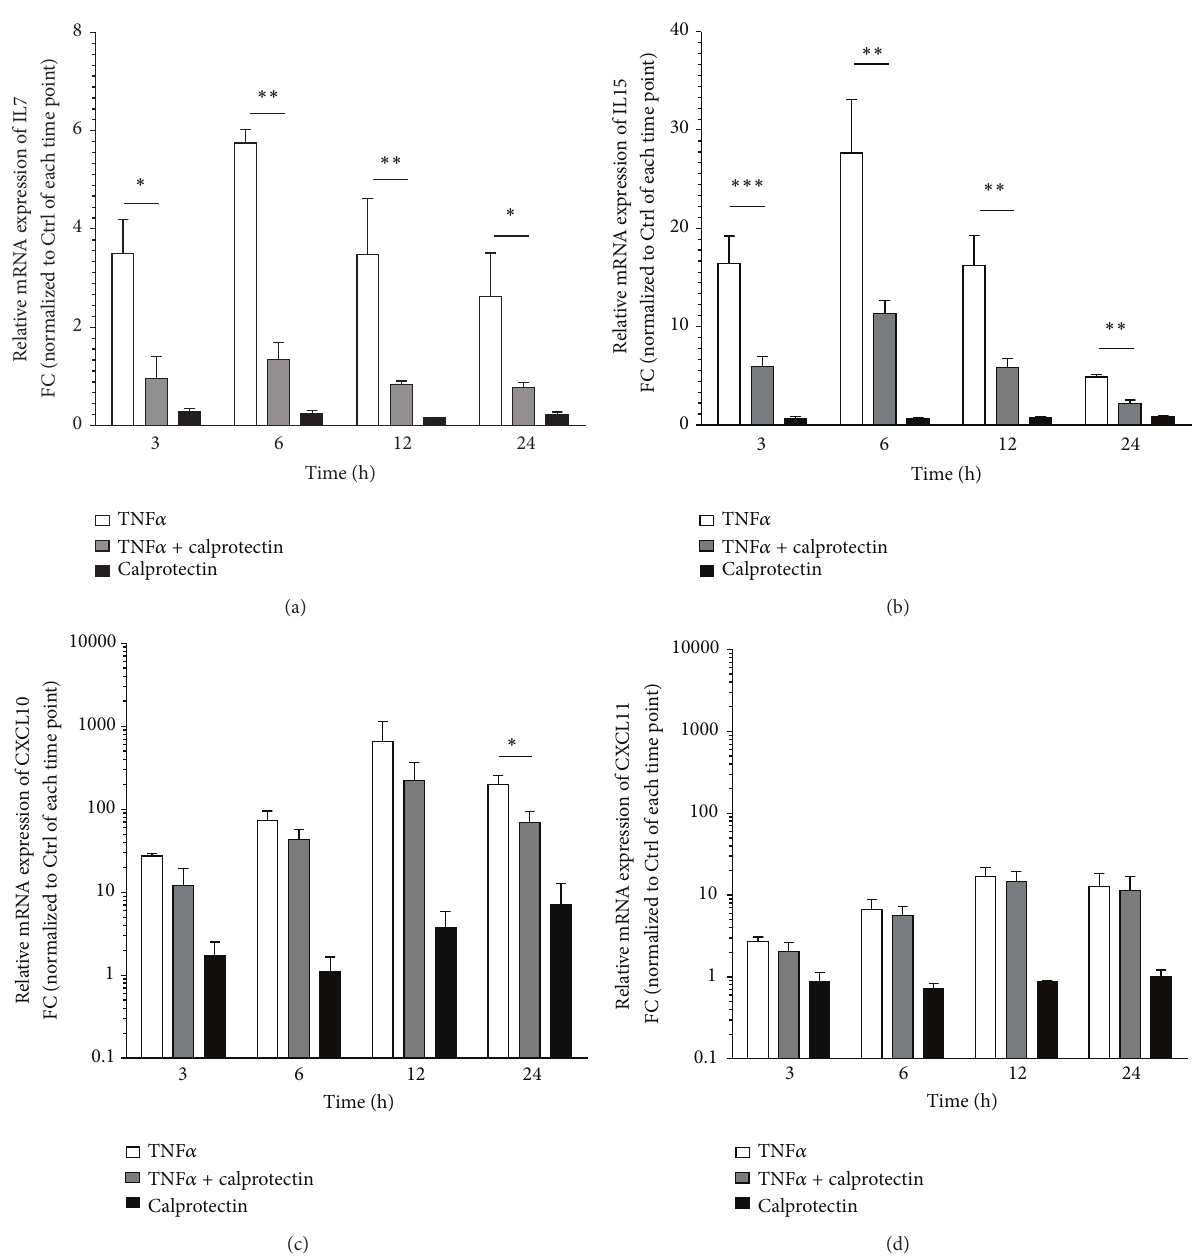
Figure 4: Effects of TNF 𝛼 , calprotectin, and TNF 𝛼 /calprotectin cotreatment on gene expression. Relative mRNA levels of IL7, IL15, CXCL10, and CXCL11 of TNF 𝛼 (2ng/mL) ± calprotectin (1 𝜇 g/mL)-stimulated HUVECs for 3, 6, 12, and 24 h are represented as mean ± SEM ( 𝑛 = 3 ). Indicated 𝑝 values are corresponding to significant differences between TNF 𝛼 and TNF 𝛼 + calprotectin: ∗ 𝑝 < 0.05 , ∗∗ 𝑝 < 0.01 , and ∗∗∗ 𝑝 < 0.001